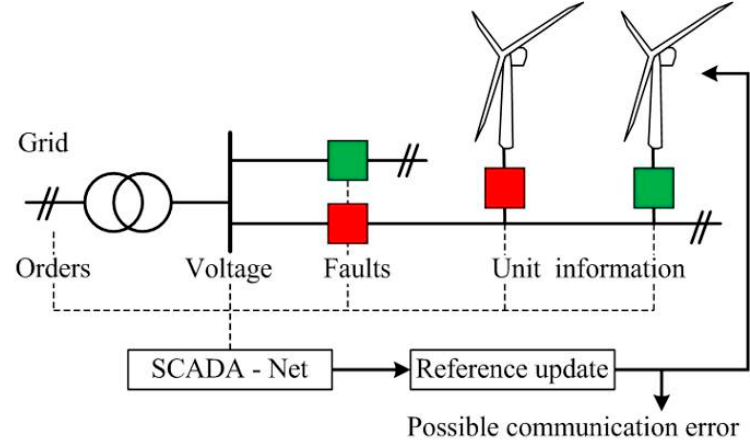
Figure 1. Online management network and data flow.